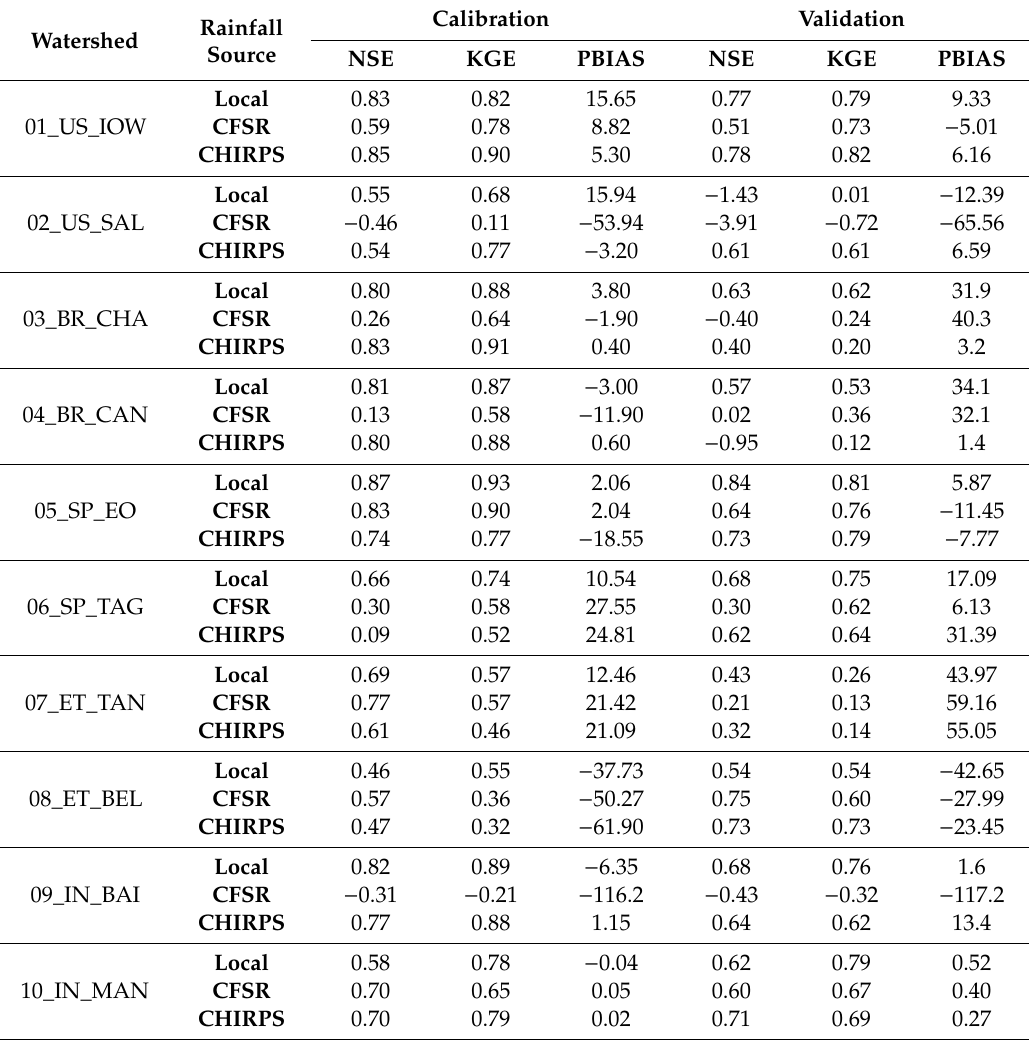
Table 6. Model performance for the calibration and the validation period at the monthly scale. Rainfall Watershed Source